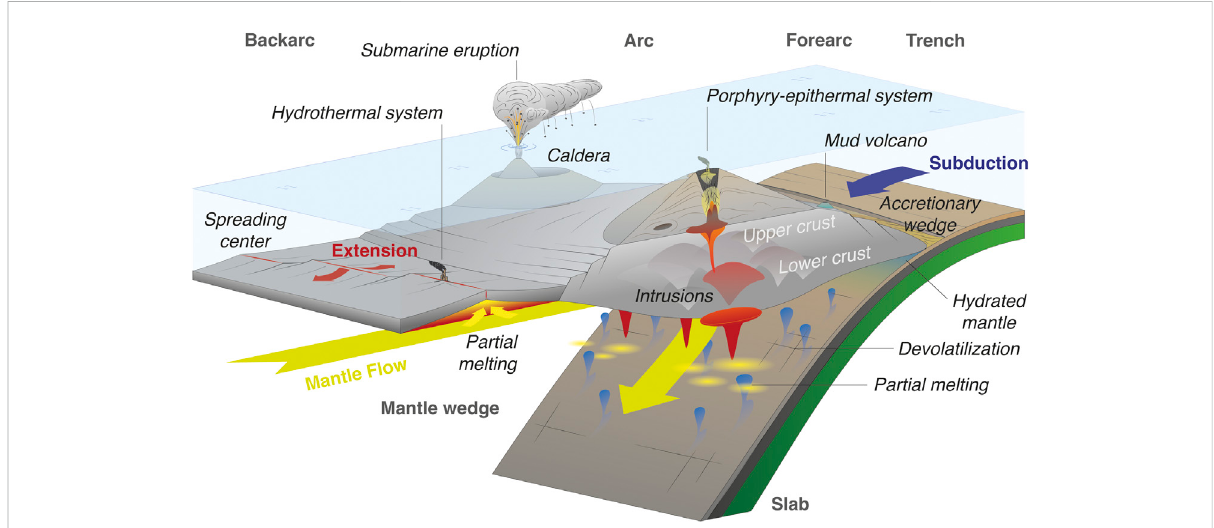
FIGURE 1 Idealized three-dimensional illustration of an intra-oceanic subduction zone and its associated arc-backarc system. Whereas partial melting underneaththearcfrontismainlycontrolledby fl uids fl uxedfromthesubductingslab,themeltingunderneathspreadingcentersinbackarcbasinsis dominatedbyadiabaticdecompressioninanextensionalstressregime.Magmatic-hydrothermaloresystemsarecommoninthesesettingsandtheir location is controlled by regional geodynamics, magmatism, and local